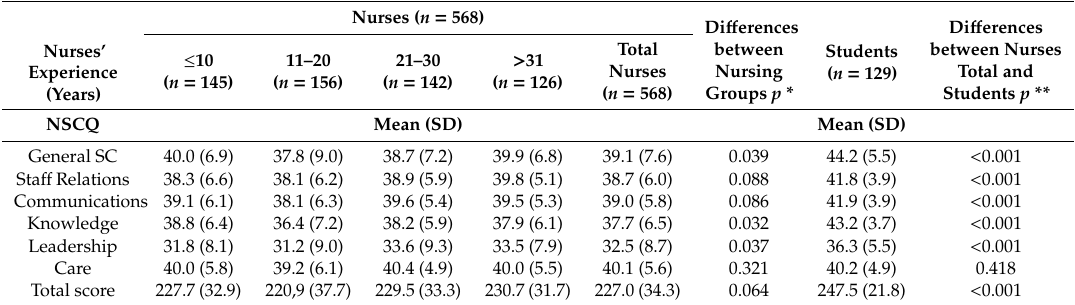
Table 3. Di ff erences in nurses’ self-concept according to their work experience, and between nurses and students.